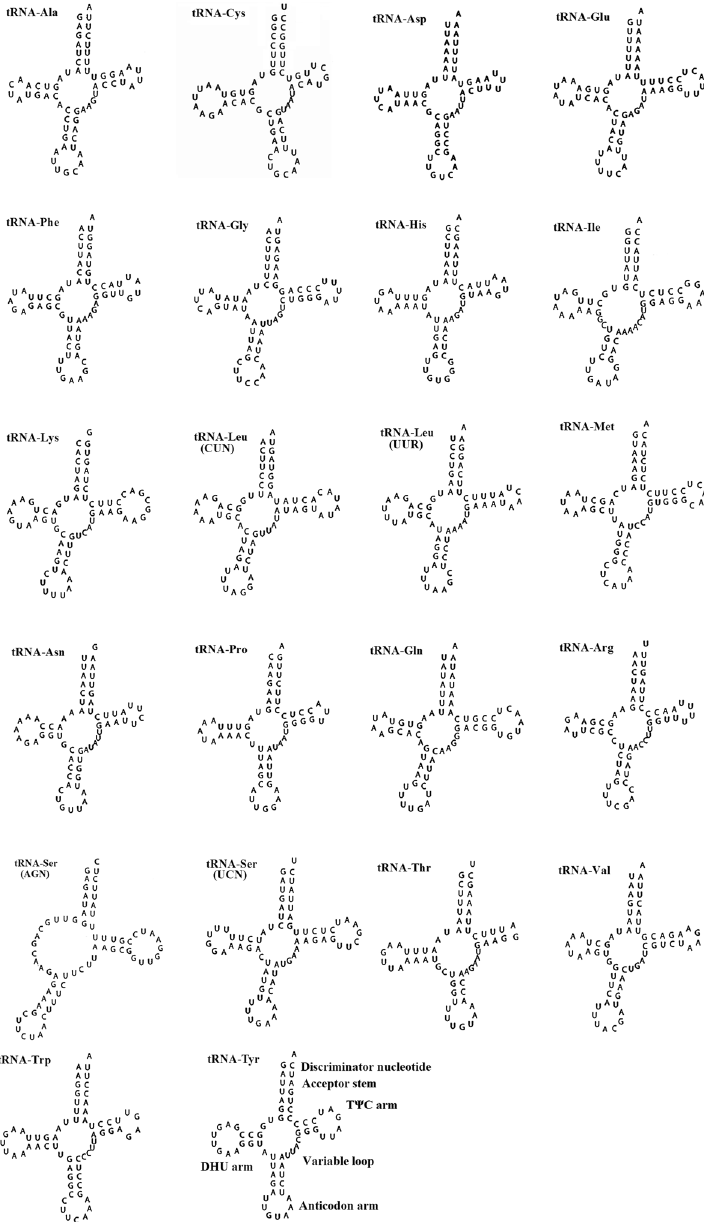
Figure 4. Putative secondary structures of tRNAs from the Exhippolysmata ensirostris mitogenome. The tRNAs are labelled with the abbreviations of their corresponding amino